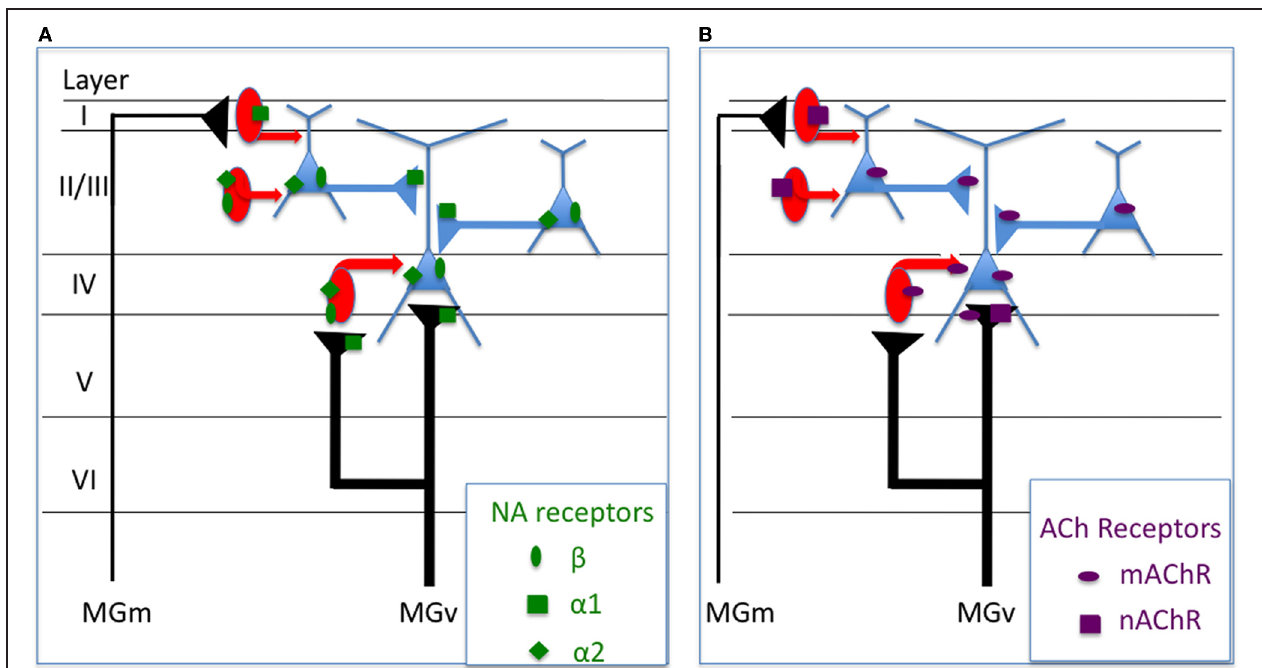
and Edeline, 1997, 1999; Salgado et al., 2011). (B) Muscarinic receptors increase the post-synaptic excitability of pyramidal cells (Metherate et al., 1992; Cox et al., 1994) but also of some types of interneurons (Disney and Aoki, 2008) and can decrease the release of GABA by Fast-Spiking interneurons (Kruglikov and Rudy, 2008). Nicotinic receptors can act presynaptically on the thalamo-cortical and can increase the excitability of several types of GABAergic interneurons (Disney et al., 2007; review in Metherate, 2004,